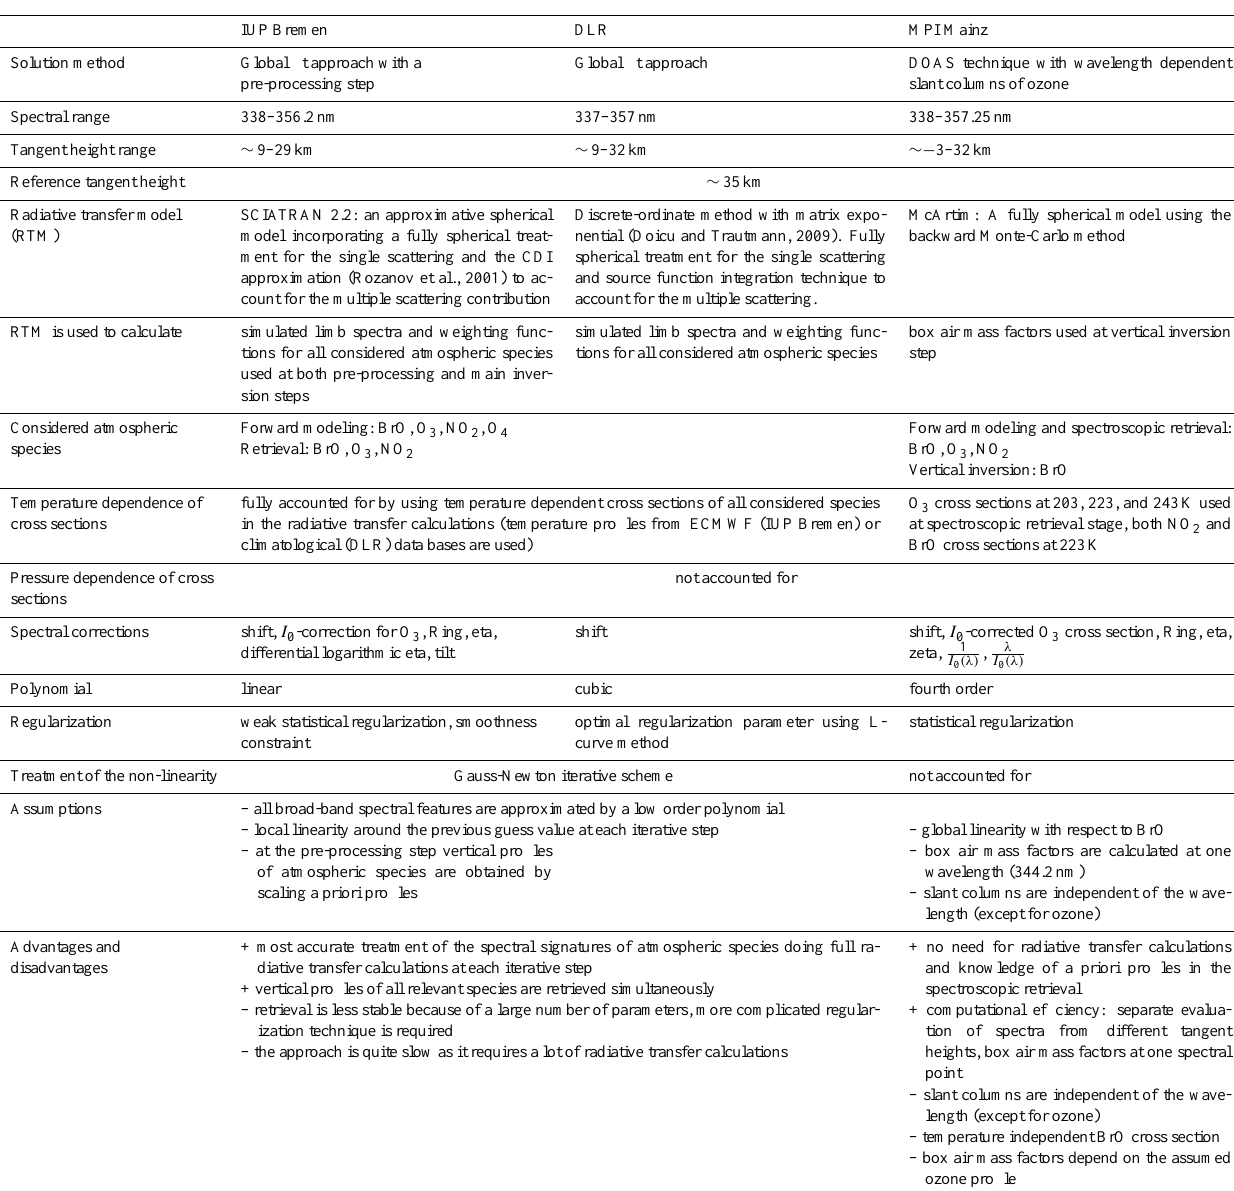
Table 1. Comparison of the retrieval algorithms: implementation details and initial